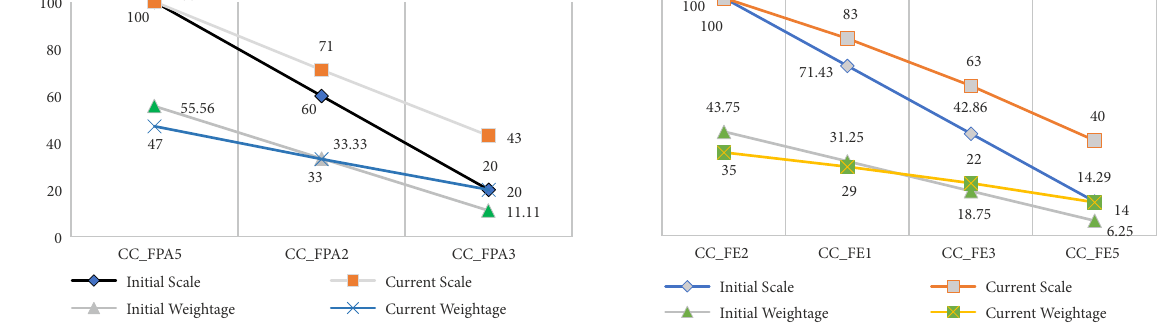
Figure A7. Model modification for sub-criteria of FPA Figure A8. Model modification for sub-criteria of